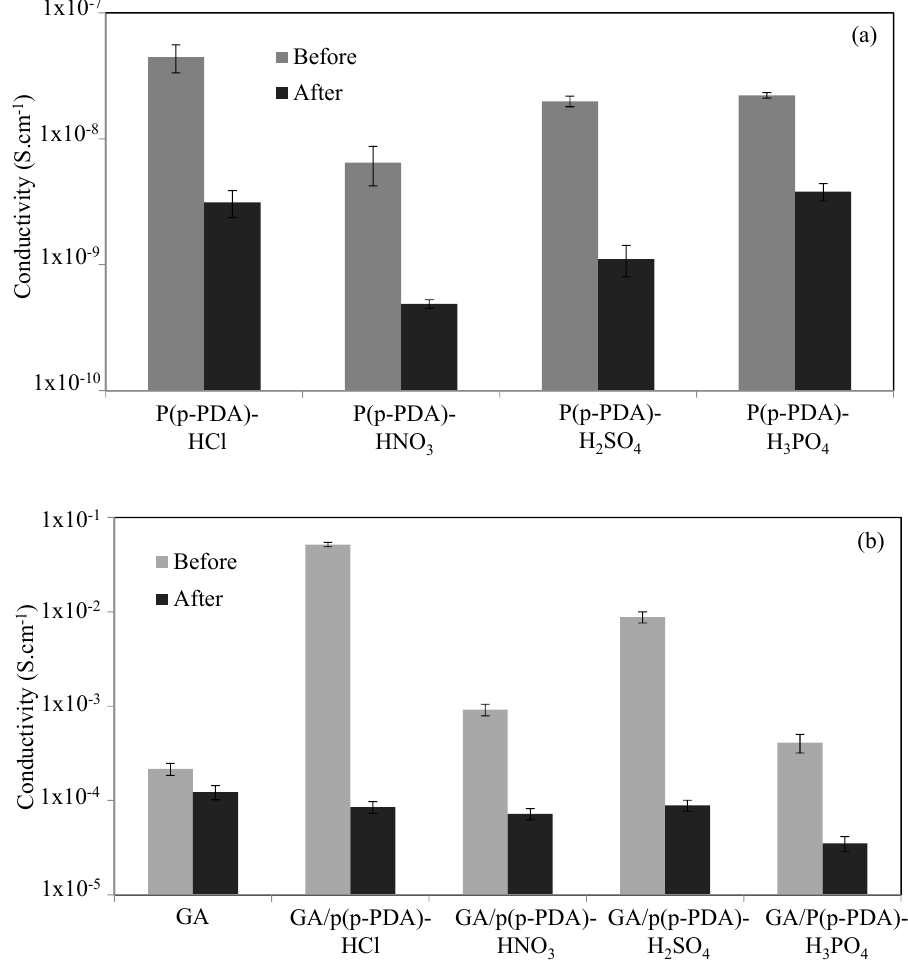
Figure 6. The conductivities of ( a ) p(p-PDA) polymers, and ( b ) GA / p(p-PDA) composites before and after 30 min of CO 2 gas exposure.